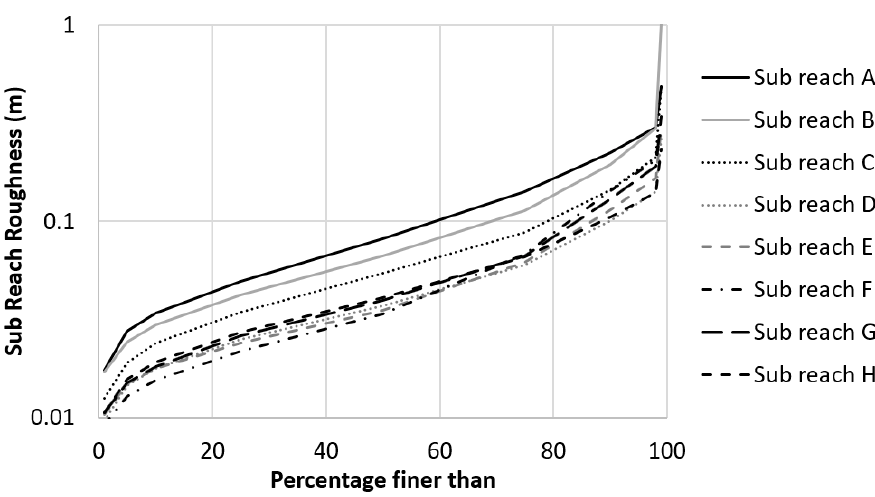
Figure 9. Downstream change in micro-surface roughness.